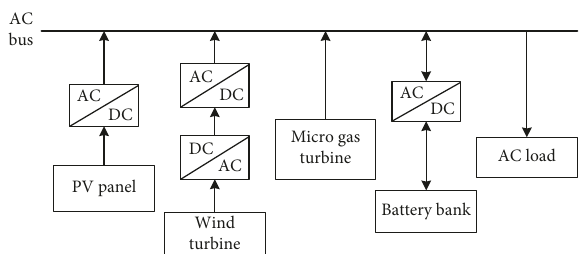
Figure 1: Multienergy network node